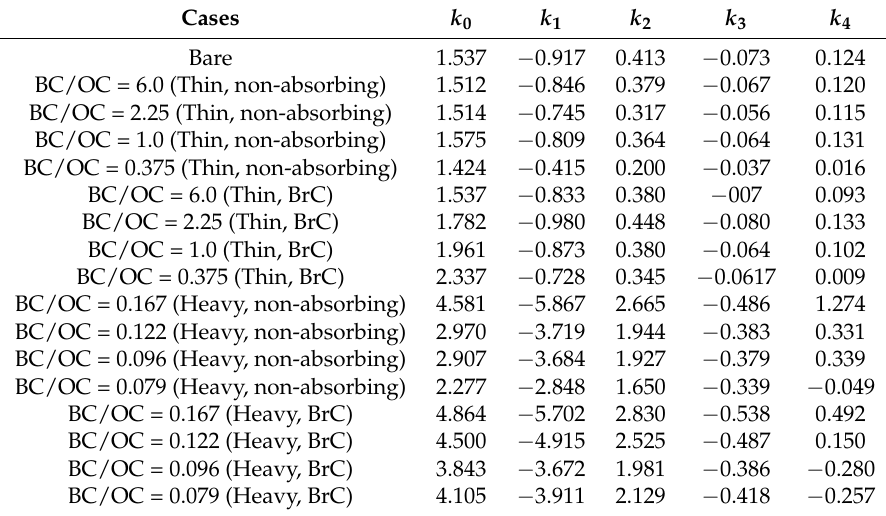
Table A1. Fitting parameters of BC aerosols for AAE (350–700 nm).